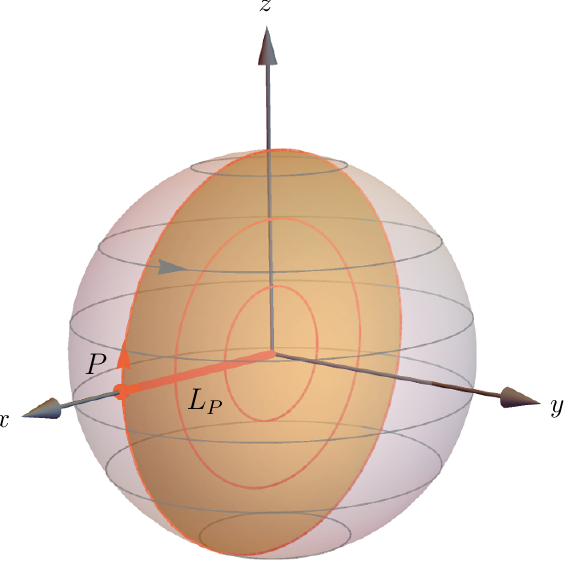
Figure 8 . Illustration of the proof that (cid:14)E r(cid:18) = 0. After showing that (cid:14)E r(cid:18) vanishes on the orange line L P , we use the ( x; z )-rotation (orange arrow) to show that (cid:14)E r(cid:18) = 0 in the orange disk. With the ( x; y )-rotation (gray arrow), we can show that (cid:14)E r(cid:18) = 0 everywhere in the ball. These transformations all have diagonal Jacobians where they are evaluated so they don’t mix (cid:14)E r(cid:18) with other